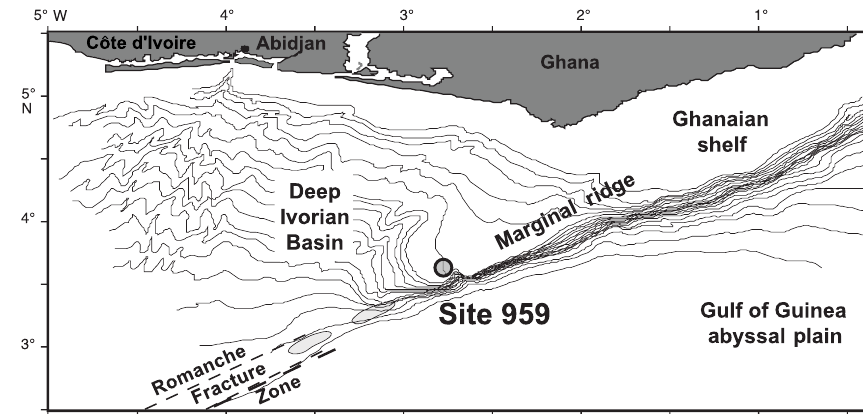
Figure 1. Map of eastern tropical Atlantic and location of ODP Site